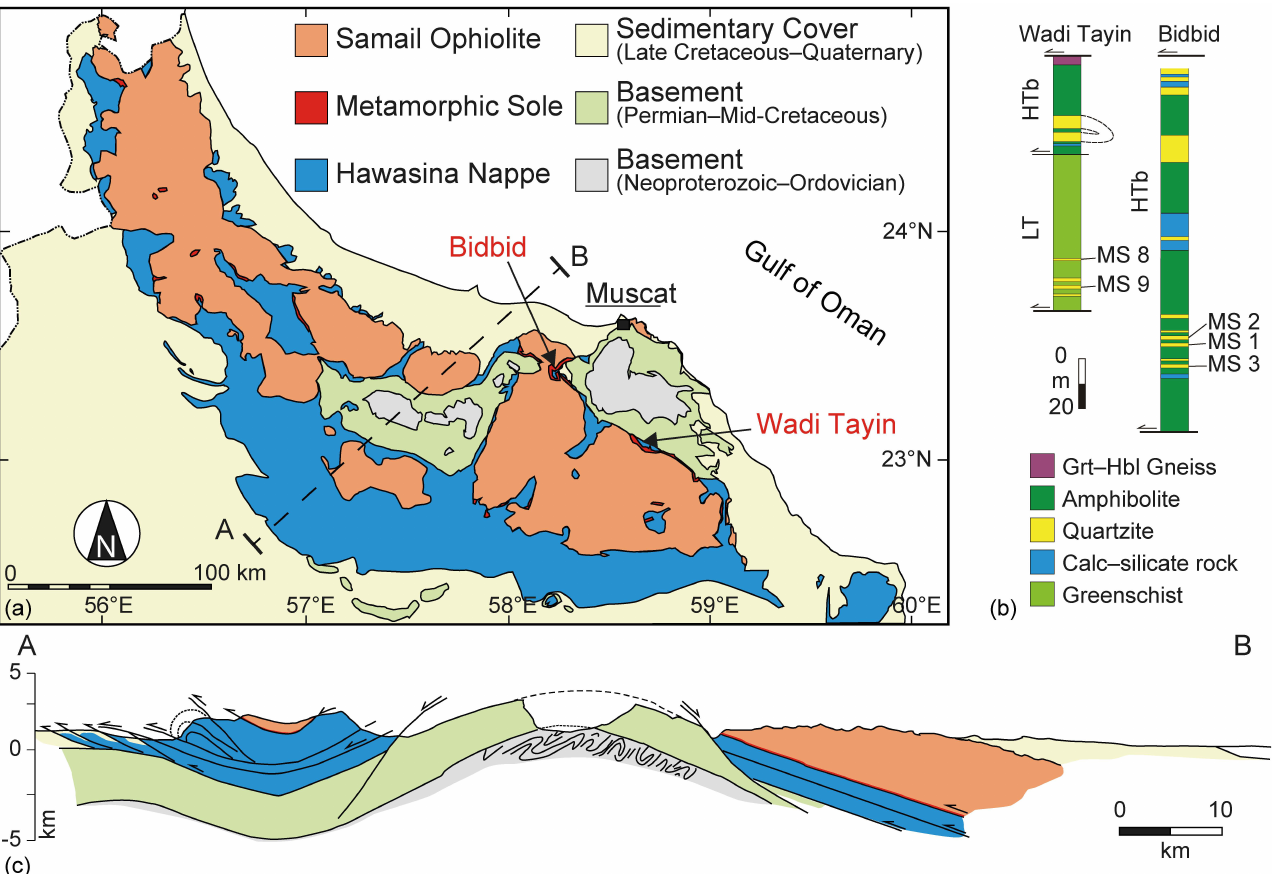
Figure 1. ( a ) Simplified geological map of the Oman Mountains in Oman (after [14]); ( b ) synoptic normal profiles of the metamorphic sole in Wadi Tayin and near the town of Bidbid, with sample locations; ( c ) cross section through the central part of the Oman Mountains, along the line A–B in the map (modified after